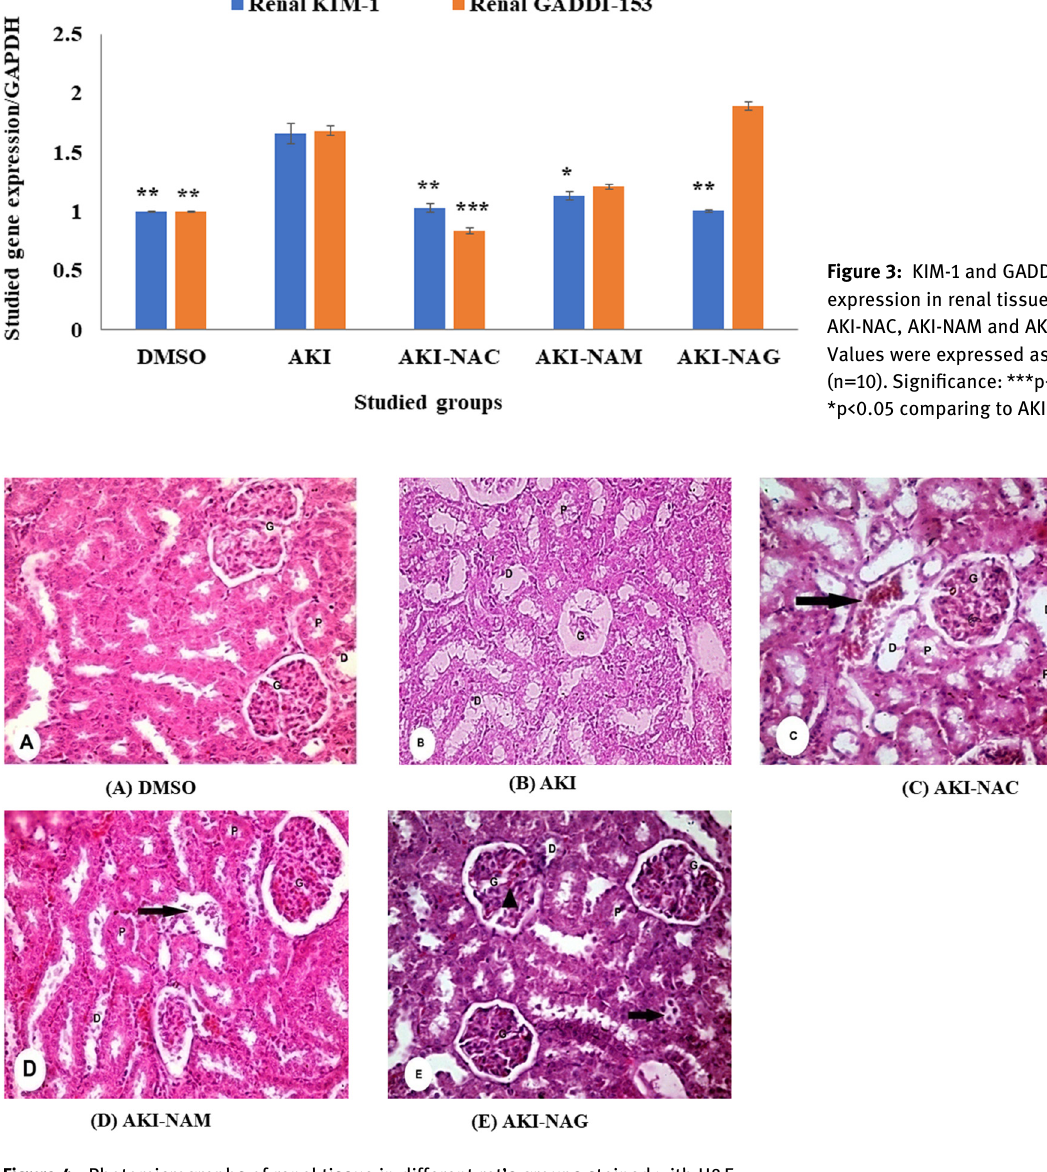
Figure 4: Photomicrographs of renal tissue in different rat ’ s groups stained with H&E. (A) DMSO, (B) AKI, (C) AKI-NAC, (D) AKI-NAM and (E) AKI-NAG (X=400).